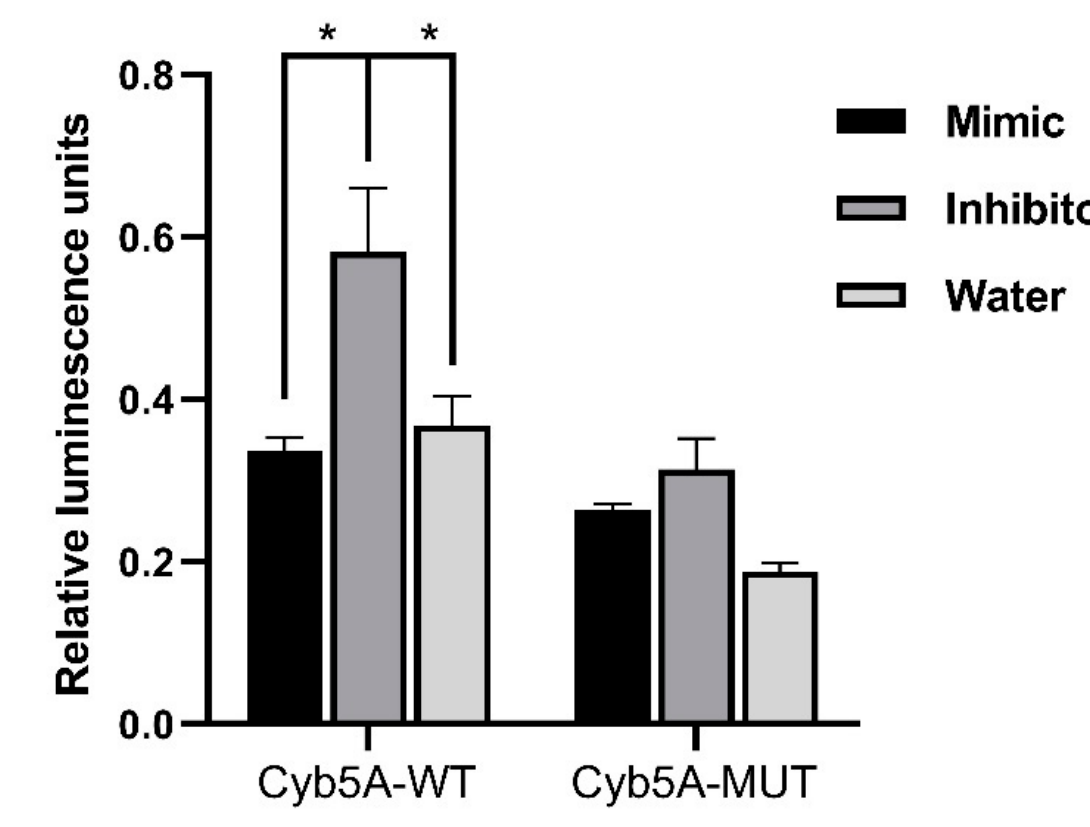
Figure 8. Results of dual luminescence assay on cells transfected with miR-1247-5p mimics and related controls. Cells were transfected with plasmids containing either the WT or Mut miRNA binding sequence in Cyb5a. Either miR-1247-5p mimics or miR-1247-5p inhibitors were transfected together with the respective plasmids. Data are represented as mean ± standard error of mean (SEM) of relative luminescence unit values. Statistics: ANOVA test with Bonferroni correction to detect significant differences between patient groups with at least a significance of p value < 0.05 (*).